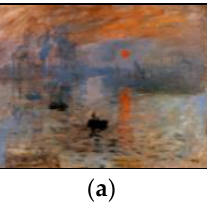
Figure 6. ( a ) Monet, “Impression Sunrise”, ( b ) Monet, “Self-Portrait”, ( c ) Van Gogh, “Cypress against a Starry Sky”, ( d ) Van Gogh, “Self-Portrait”, ( e ) Seurat, “A Sunday Afternoon on the Island of La Grande Jatte”, ( f ) Seurat, “Model”.